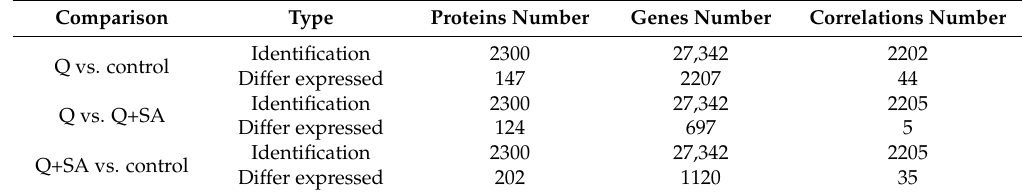
Table 3. Correlation analysis of transcriptomic and proteomic data under different